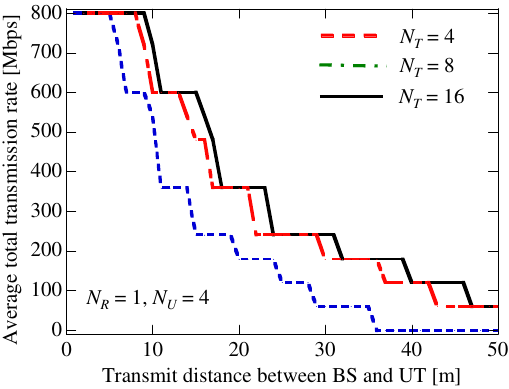
Figure 12. Transmission rate (TR) vs. distance between base station (BS) and user terminal (UT) for different N T